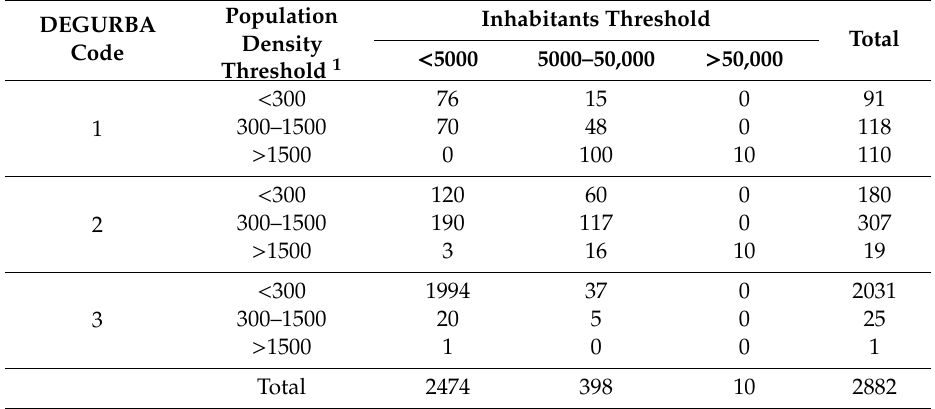
Table2. NumberofparishesbyDEGURBAclassification, populationdensity, andnumberofinhabitants.